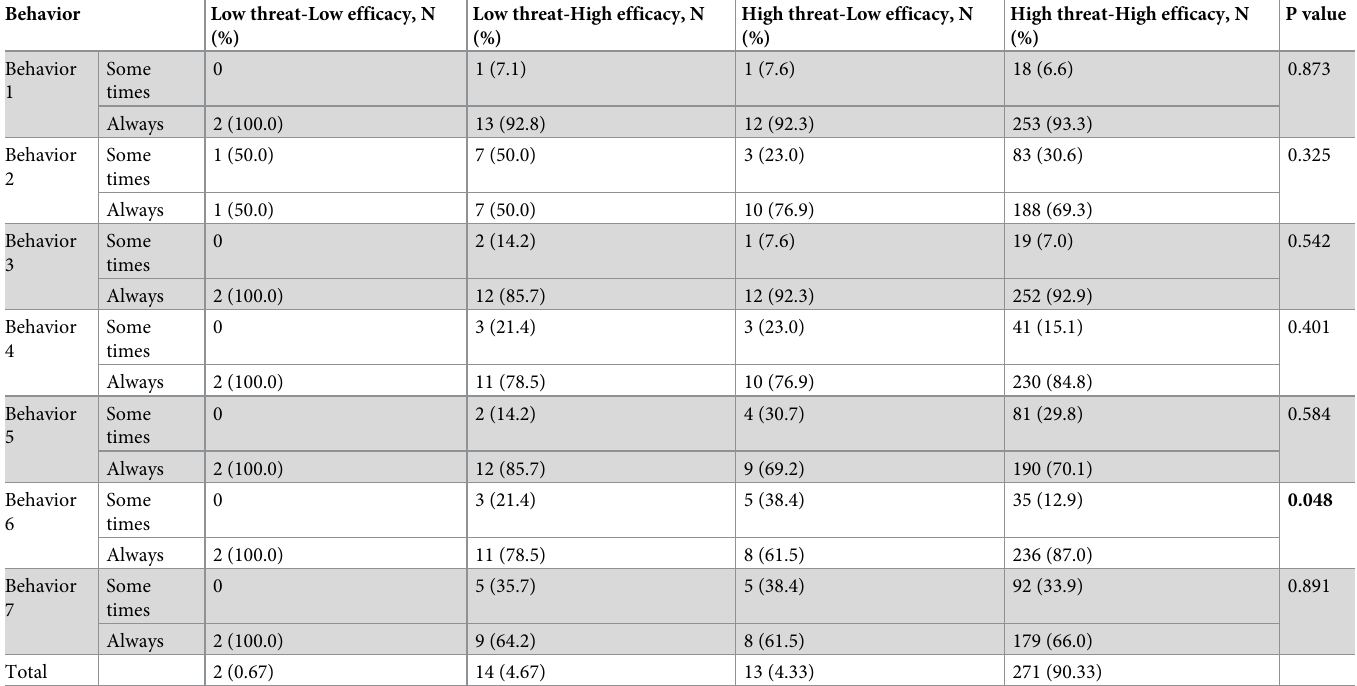
Table 3. Health behaviors regarding COVID-19 epidemic in oral health care providers in different levels of the